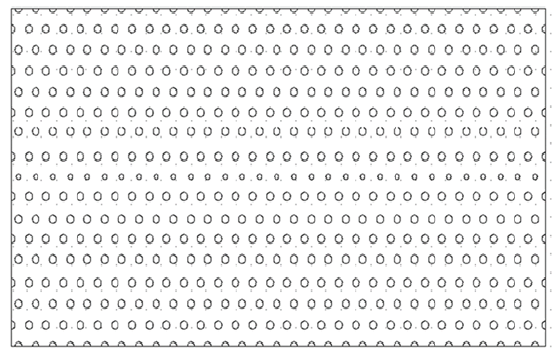
Figure 1:A periodic structure from dielectric photonic crystal